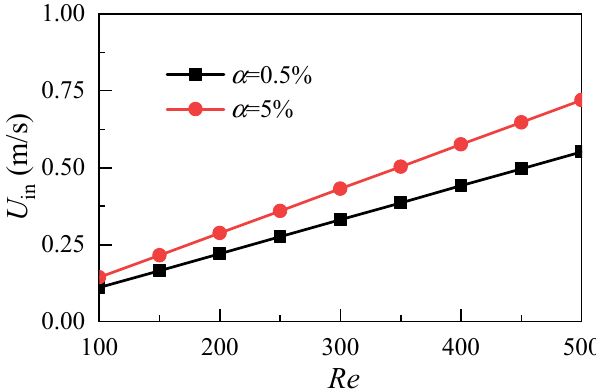
Figure 8. Effect of nanoparticle volume fraction on inlet velocity.